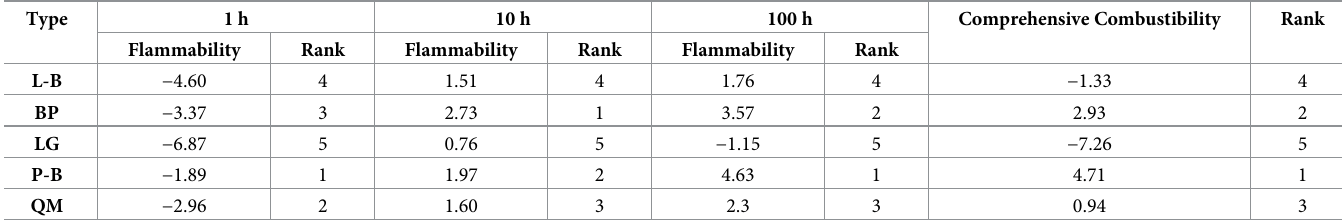
Table 3. Comparison of comprehensive flammability